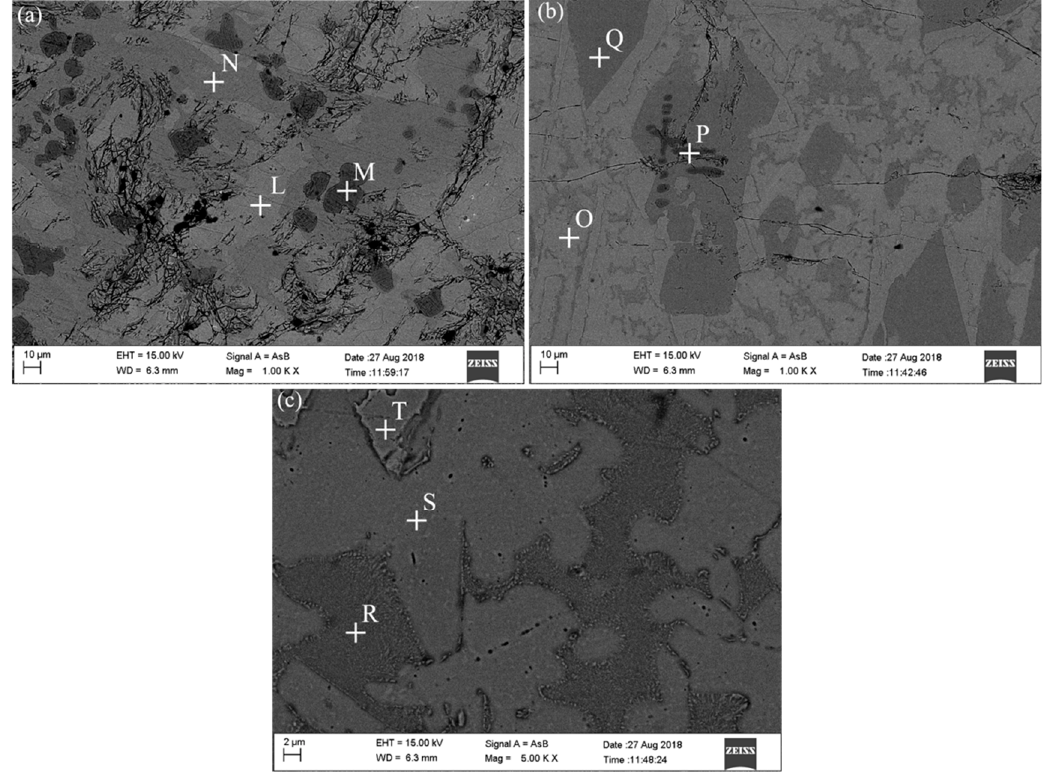
Figure 7. Microstructures of ferrotitanium produced from ilmenites with different reduction degrees. ( a ) 0%, ( b ) 75%, and ( c ) 75%.